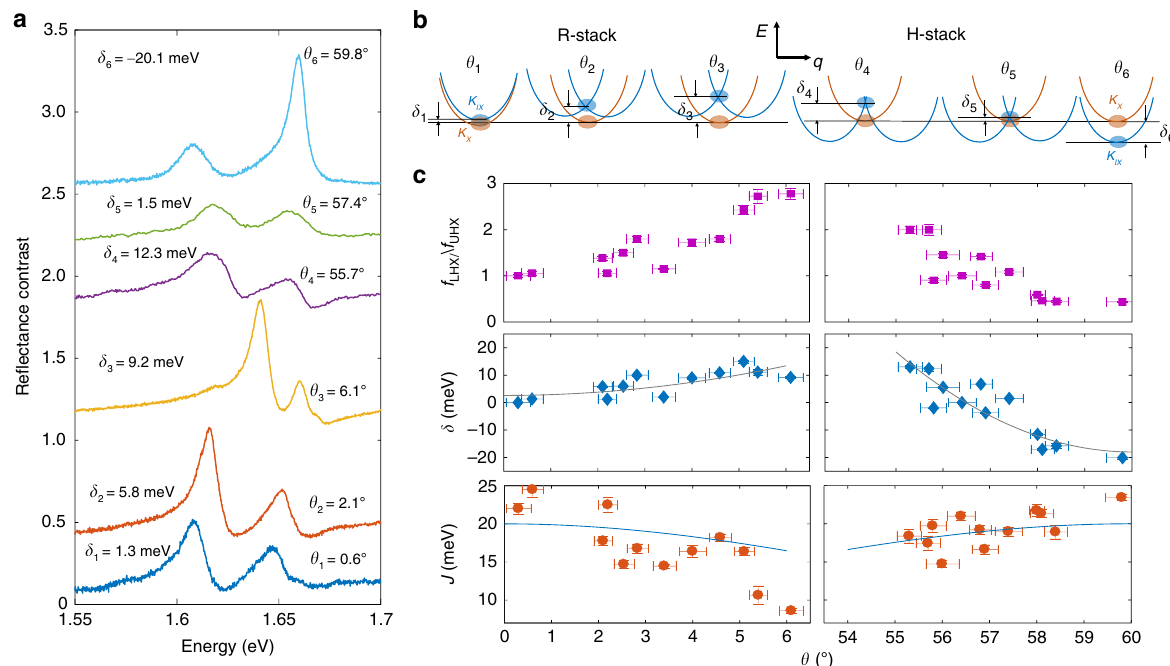
Fig. 2 Twist-angle dependence of the hybrid excitons. a RC spectra of bilayers of different twist angles θ i , for i = 1 – 6. The corresponding θ i and extracted detuning δ i = E IX, i − E X, i are labeled by each spectrum. The spectra are displaced vertically for easier reading. b Schematics of MoA intralayer (red) and interlayer (blue) exciton bands at the different twist angles θ i . The interlayer exciton band is displaced in the momentum space with increasing θ i . The moiré superlattice leads to band folding and formation of a new interlayer exciton state at the Γ point q = 0 (blue oval), with the same angular momentum as the intralayer exciton state (red oval). c Ratio of the oscillator strengths of LHX MoA and UHX MoA , detuning, and inter- and intralayer exciton coupling strength as a function of the twist angle θ , obtained from the RC spectra. The gray solid lines in the middle panel are quadratic fi ts based on Eq. (1). The blue solid lines in the bottom panel are the theoretical values based on Eq.